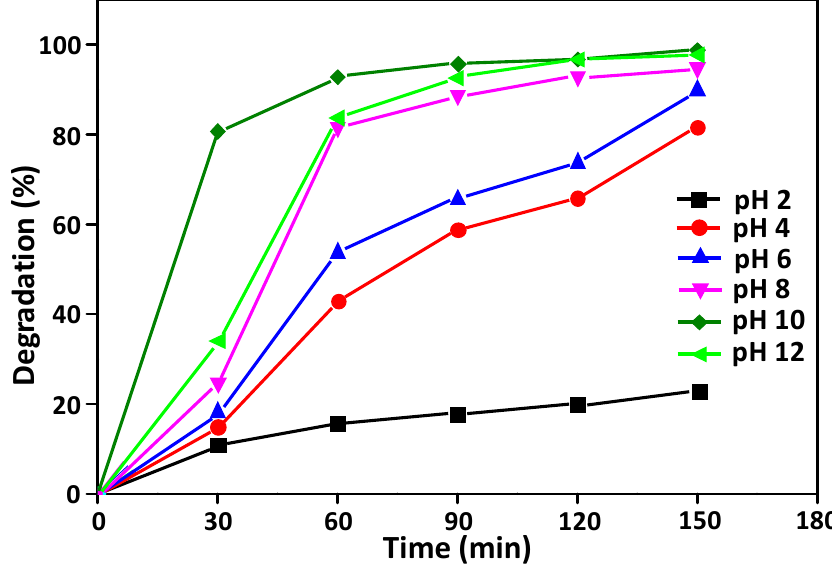
Figure 11. Degradation of MB with varying pH in the solution, constant catalyst load (B1) and dye.